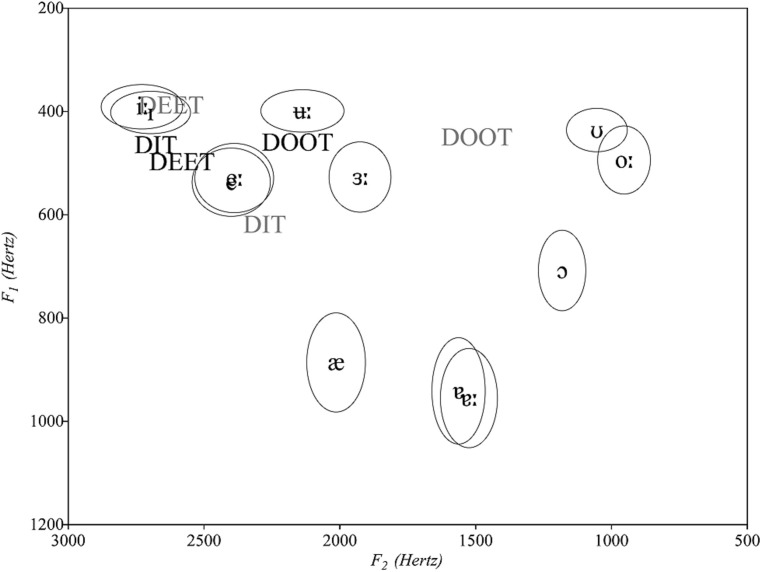
Familiarization image (A) and pre- and post-test image (B). Visual stimuli were the same as those used in Curtin et al. (2009).